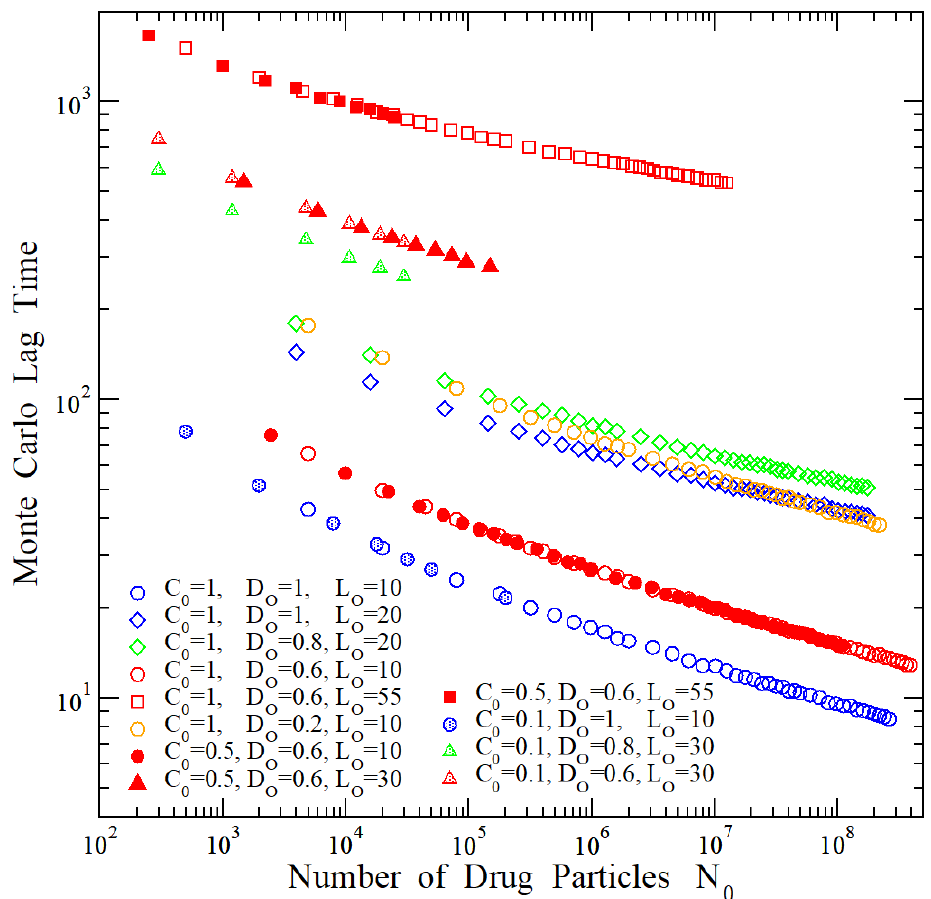
Figure 8. Numerical results of the lag times obtained by Monte Carlo simulations as a function of the total number of drug particles N 0 . Different symbols correspond to different sets of parameter values regarding the initial drug loading C 0 , the outer layer diffusivity D O , and the outer layer thickness L O , according to the labelling. Lag times have been averaged over 500 Monte Carlo realizations.